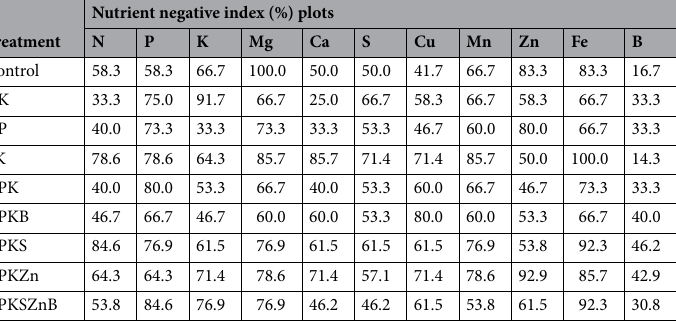
Table 5. Percentage of fields with negative DRIS indices for various nutrient